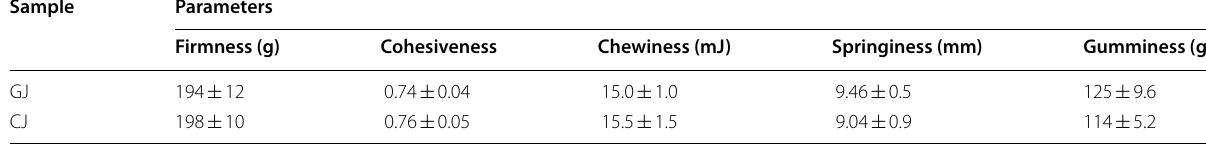
Data is expressed as mean